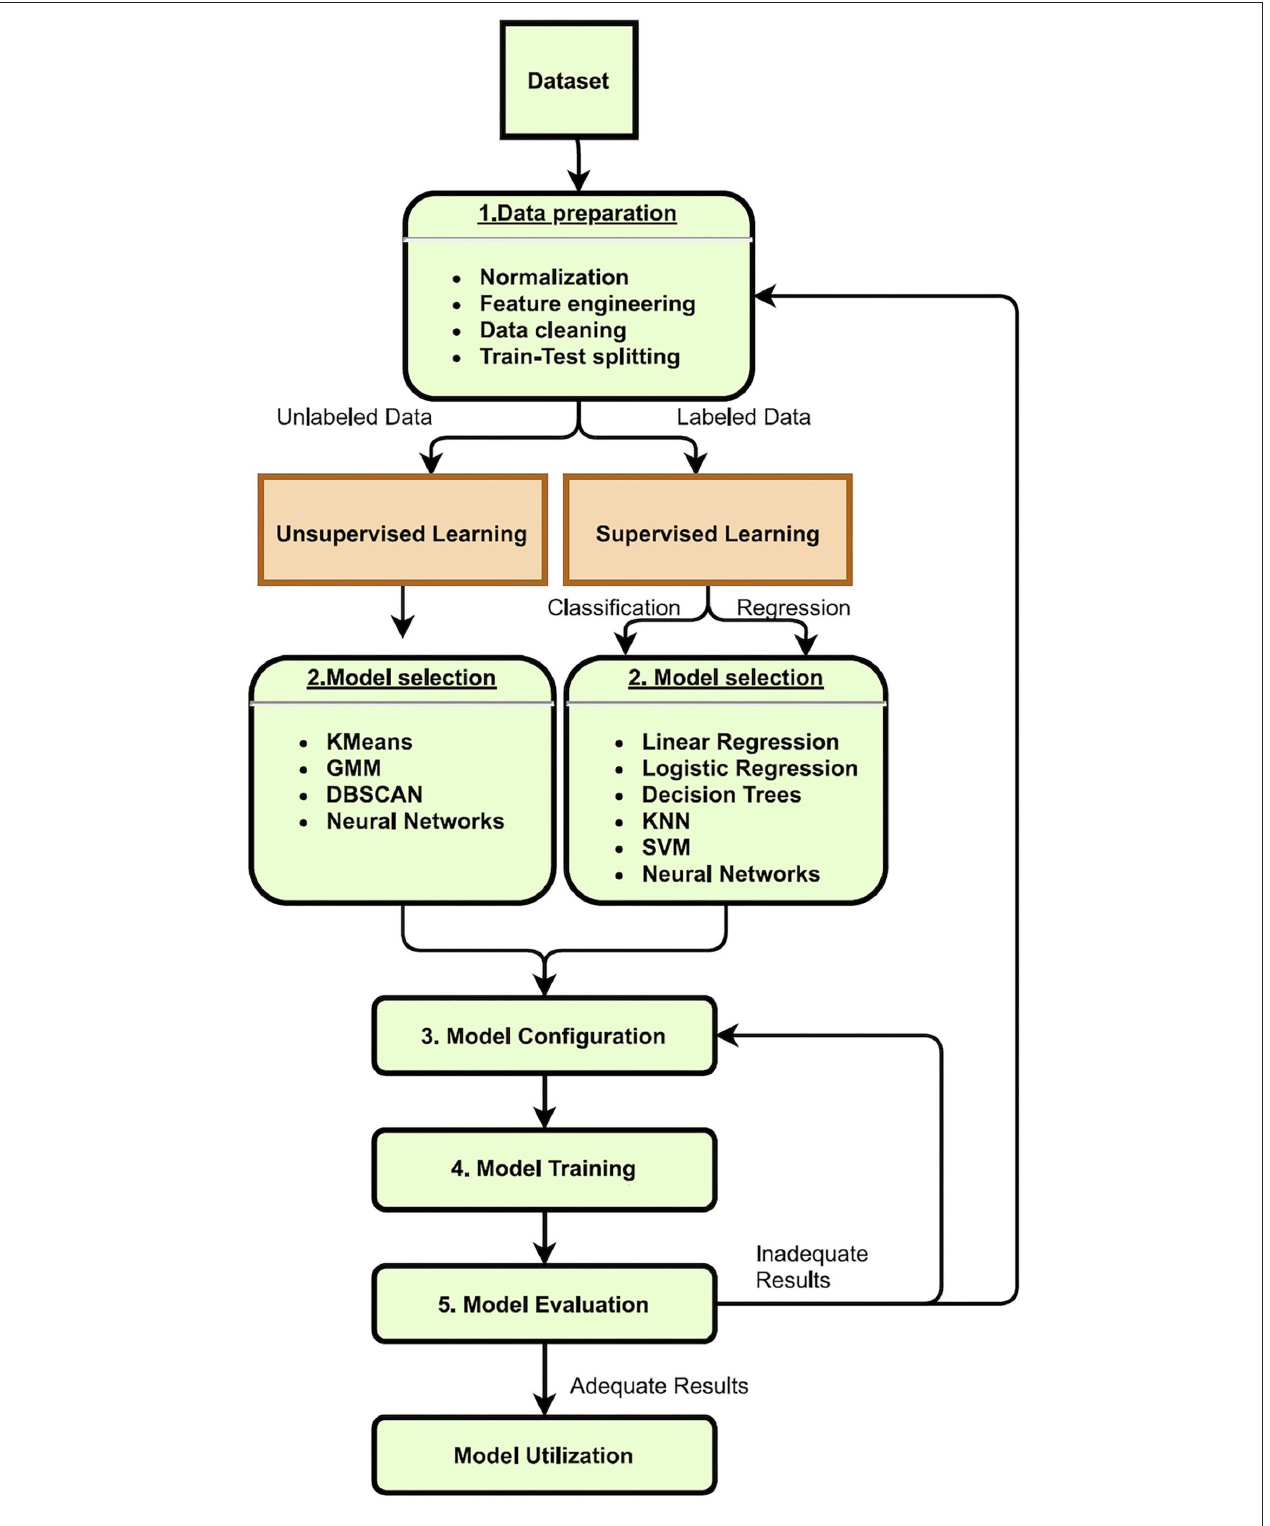
FIGURE 4 | Machine learning pipeline: (1) Data preparation is the step where modifications to the dataset are made to improve the final results. That includes transforming, cleaning, and creating new features (feature engineering). In this step, the train-test data splitting can also be defined. (2) Model selection is the step where the appropriate model is chosen. That can significantly vary according to the dataset characteristics (like size and dimensionality) and the target variable. (3)